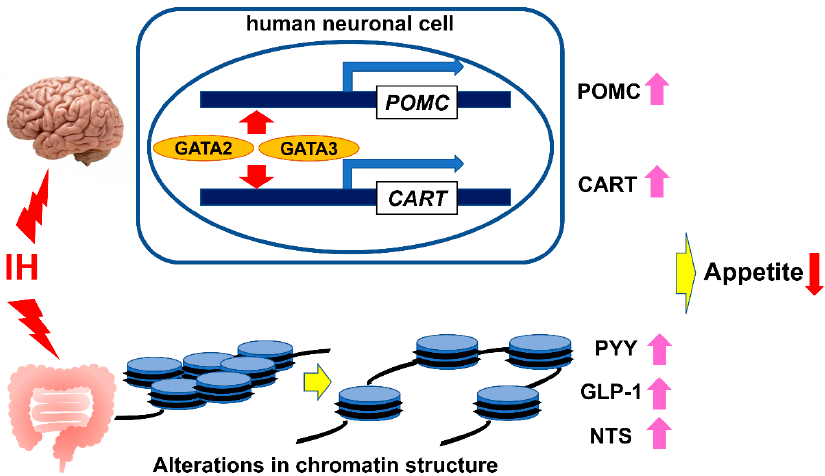
Figure 1. Schematic diagram of the effect of IH on the gut–brain axis with respect to appetite regu- lation. IH may have anorexigenic effects on the gut–brain axis by upregulating POMC and CART mRNAs via GATA transcription factors (GATA-2 and GATA-3) in neuronal cells [35], and by up- regulating PYY , GLP-1 , and NTS mRNAs via an alteration in chromatin structures of the PYY , GLP- 1 , and NTS genes in enteroendocrine cells [42].